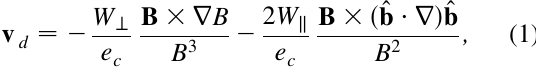
FIG. 6. Axial slices of plasma density n 35 – 40 (cid:1) s ) at x (cid:6) 0 and y (cid:6) (cid:7) 9 : 5 cm . Steady-state profiles begin at t (cid:2) 20 (cid:1) s . Of the plasma that reaches y (cid:6) (cid:7) 9 : 5 cm , (cid:2) 50% has been coupled into the guide